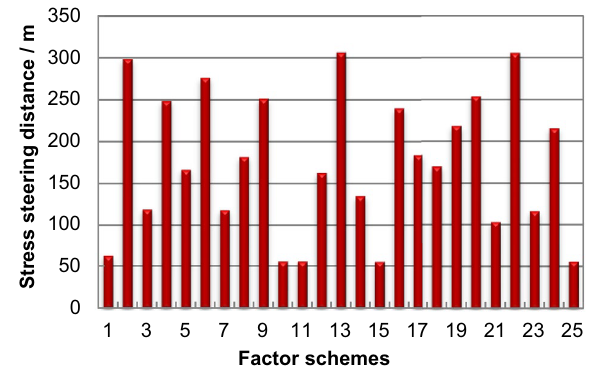
Fig. 7 The results of the stress steering distance under different factor schemes